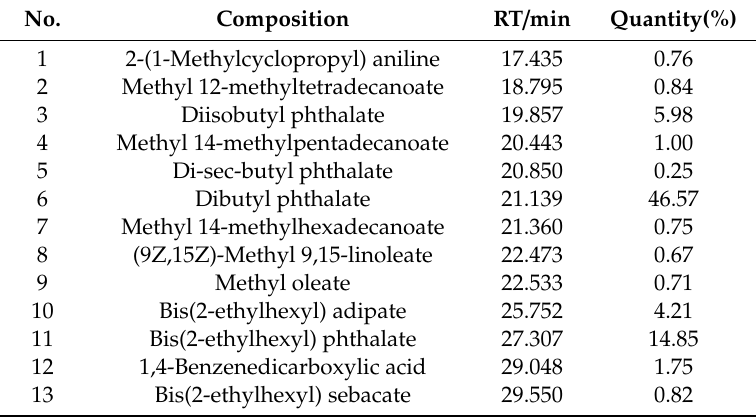
Table 1. The chemical composition of petroleum ether (1.D).